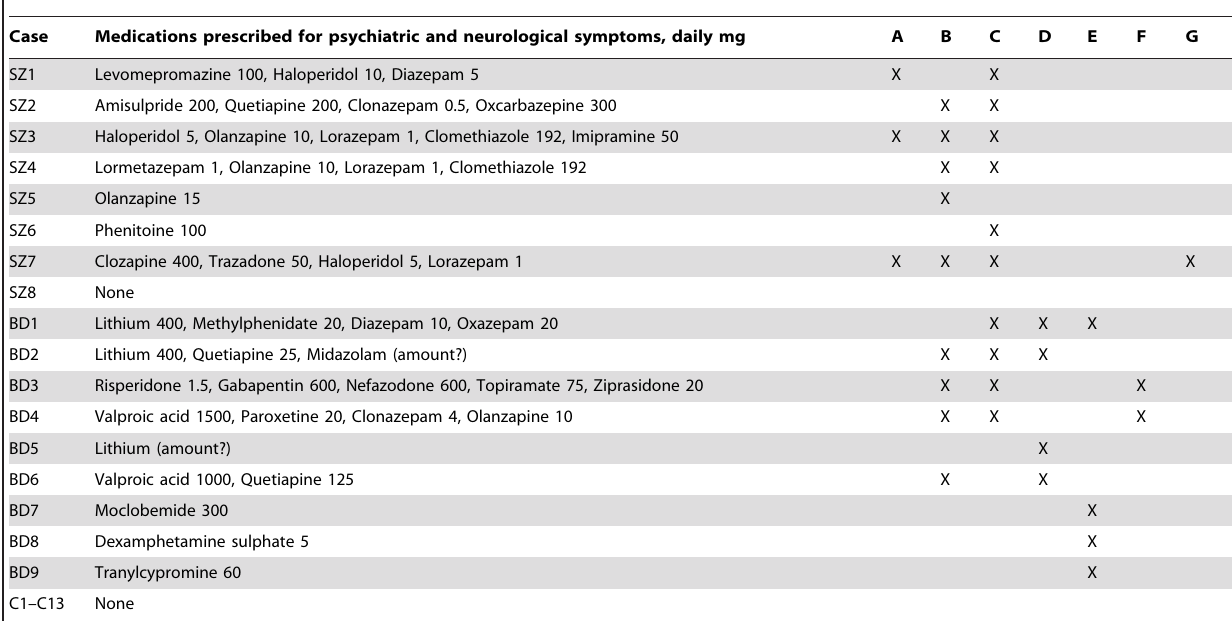
Table 4. Medications (grouped in classes A-G) prescribed to subject cases for psychiatric and neurological symptoms.